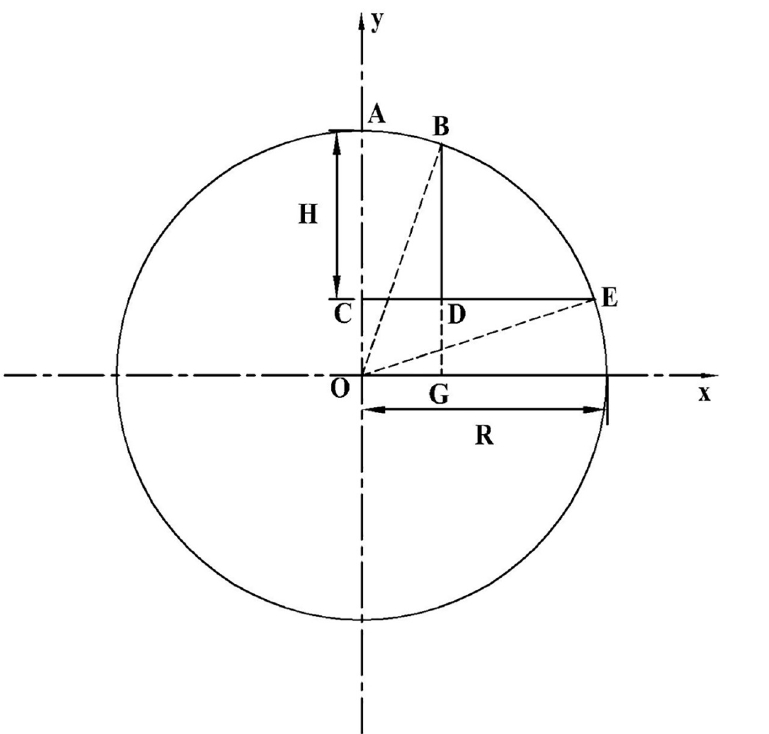
Fig 3. Geometric diagram of the bottom of the